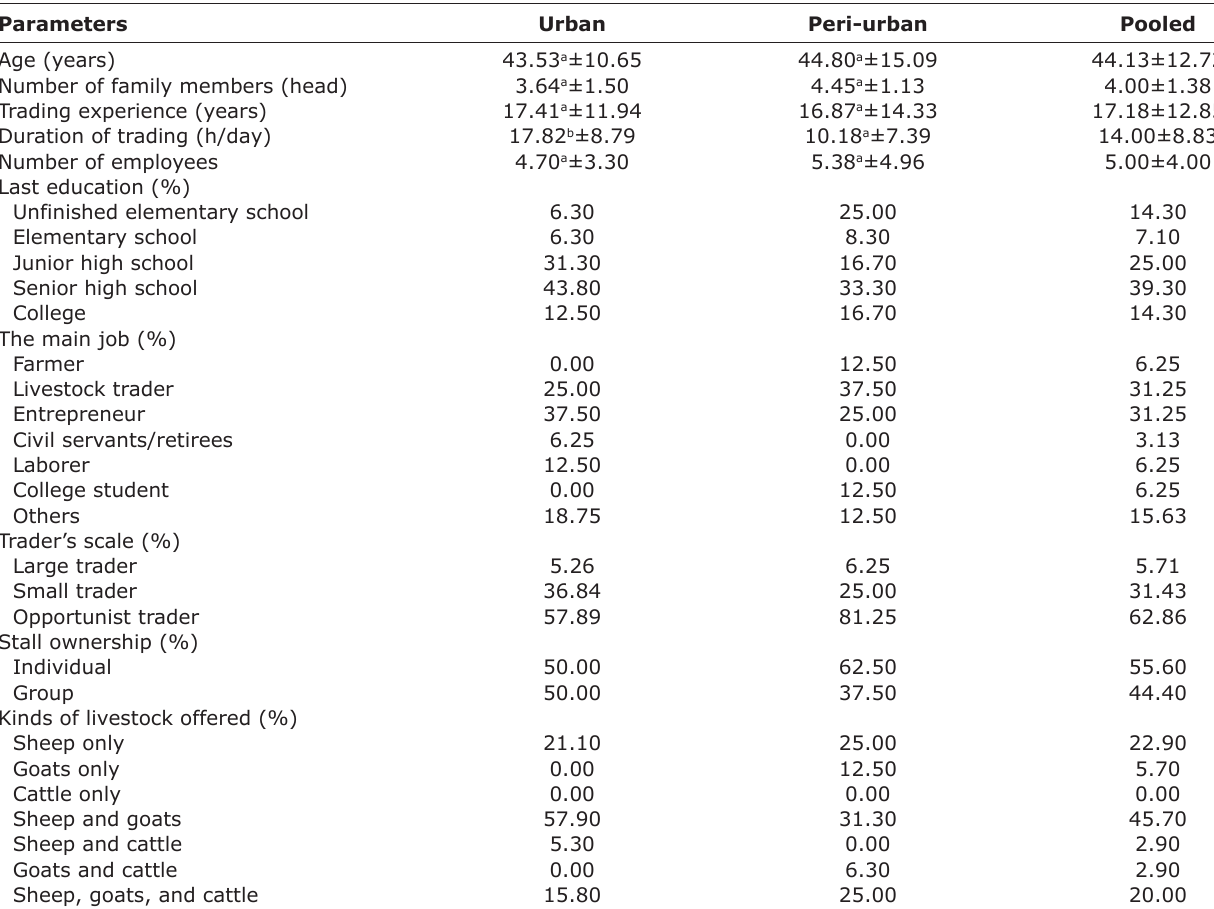
Table-1: Demographic profile of roadside livestock traders. Parameters